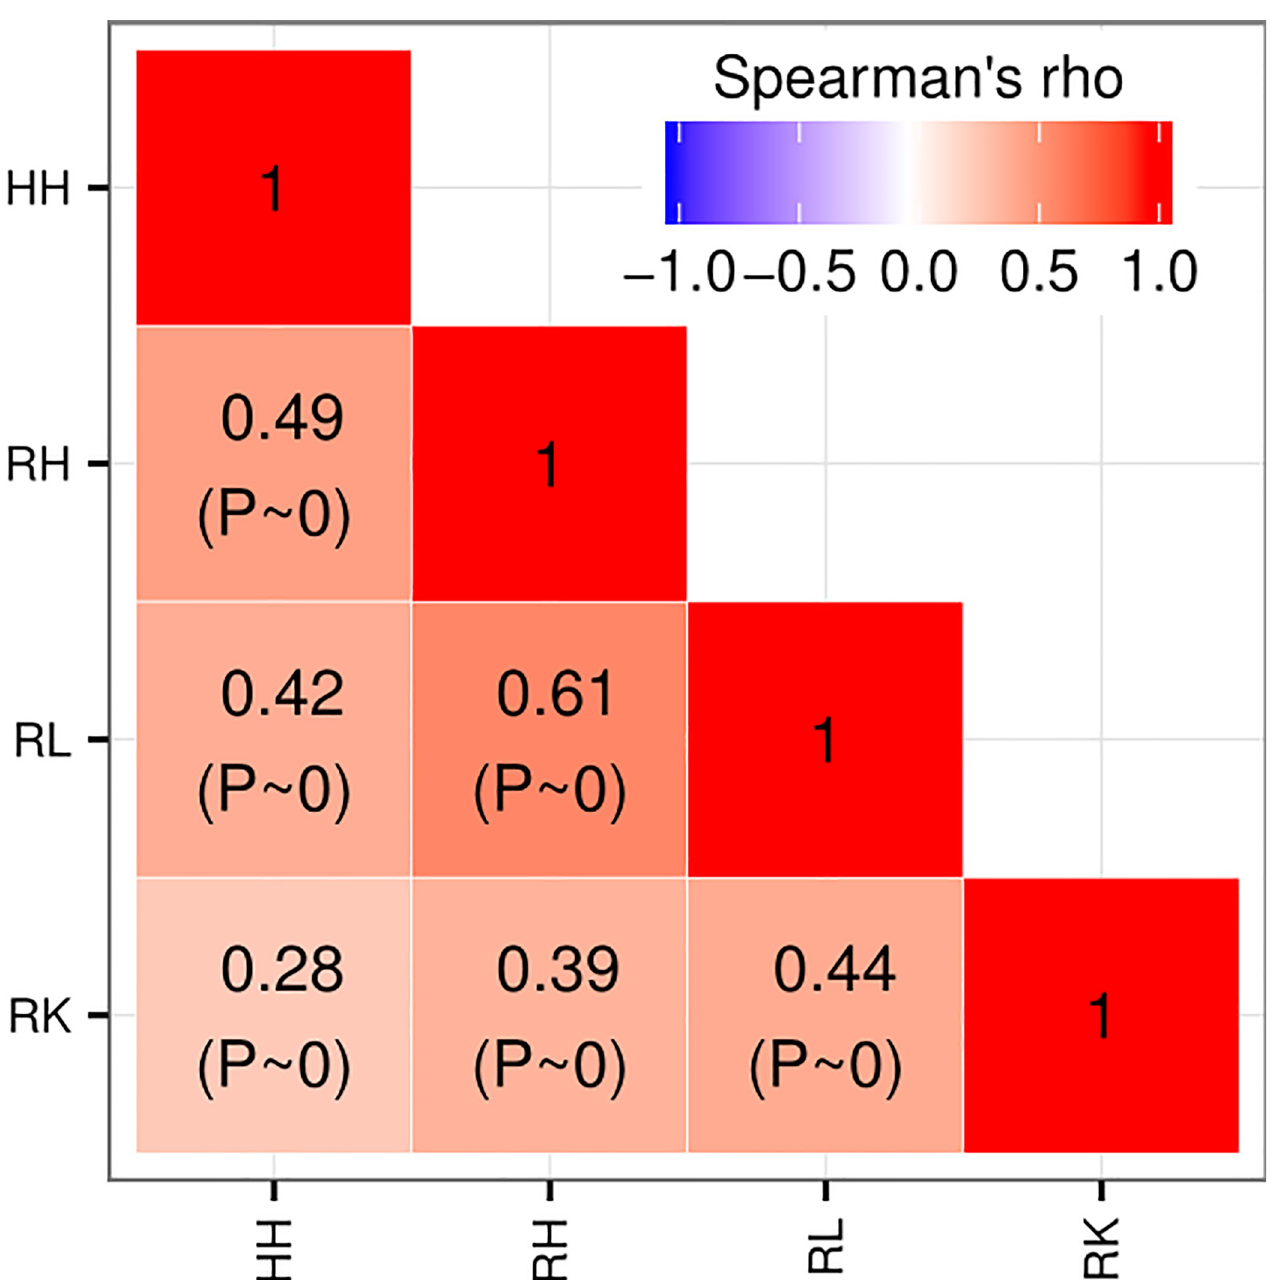
Fig 3. Comparison of AR-ranked gene sets across model systems. Rank correlation between the model system-specific gene rankings as measured by the Spearman’s rho correlation coefficient.